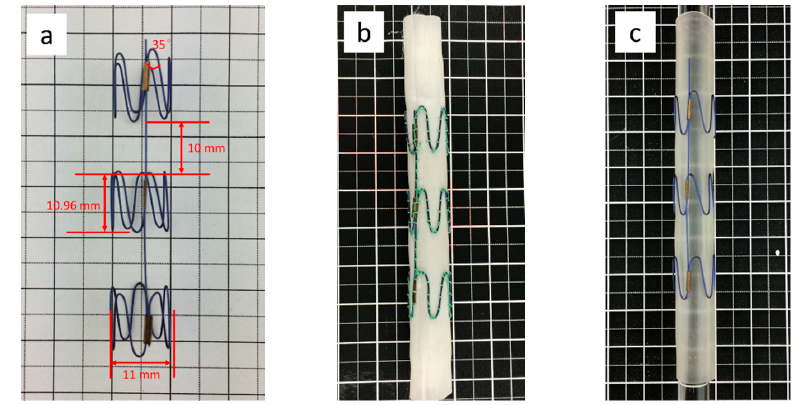
Figure 2. ( a ) Nitinol stent; ( b ) nitinol-PET stent graft; ( c ) nitinol-PU stent graft.